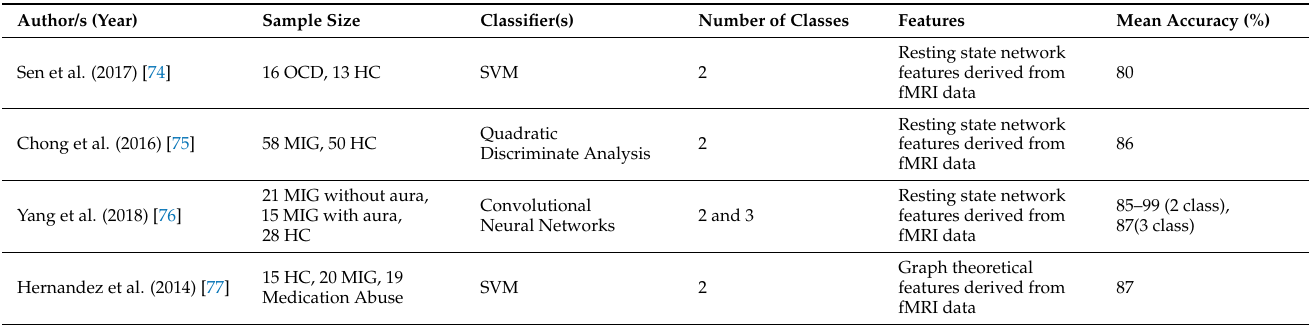
Table 3. Comparison of the classification performances of the discussed